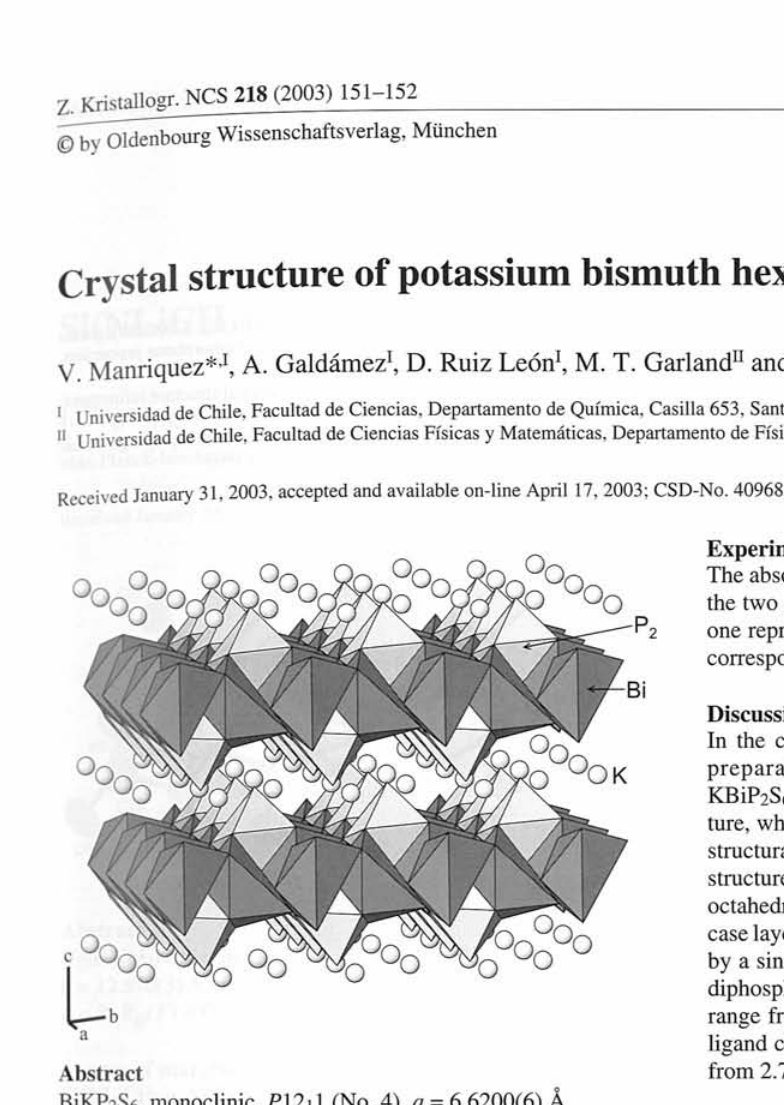
Table 1. Data collection and handling.